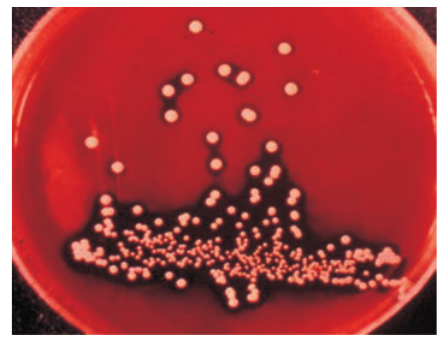
Figure . Echocardiography found vegetation in triscupidal valveFigure